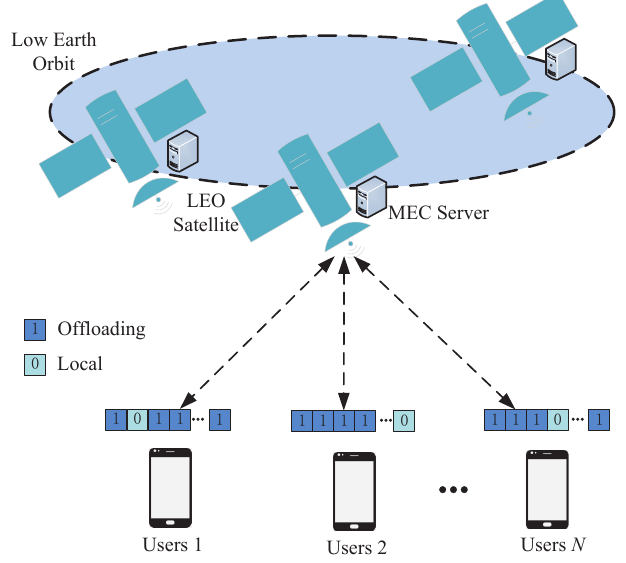
Figure 1. LEO satellite edge computing